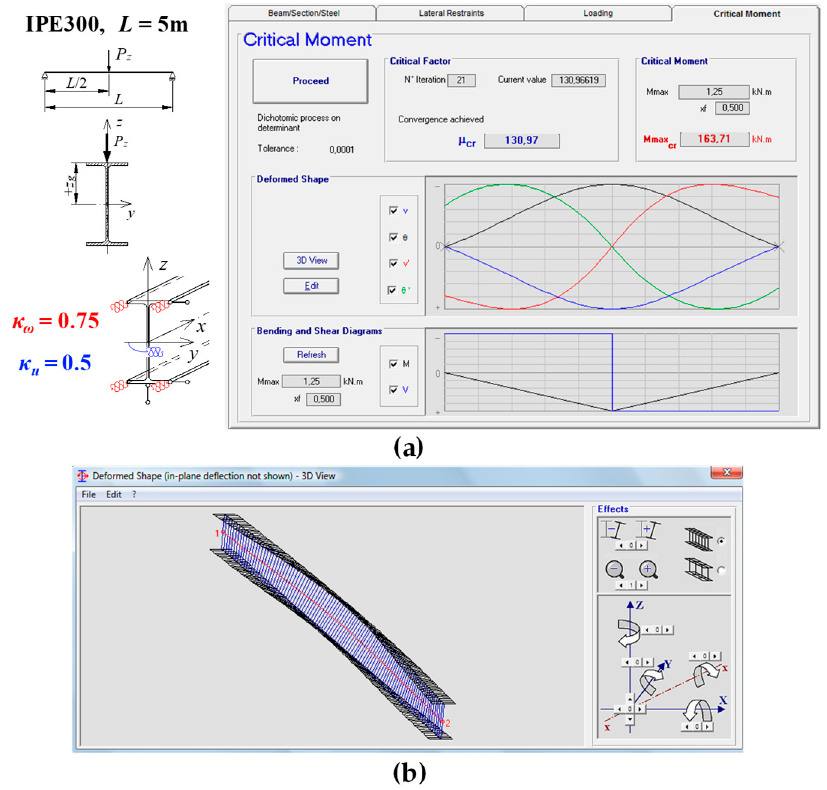
Figure 3. Exemplary beam modeled using the LTBeam software: ( a ) the critical moment for lateral torsional buckling of beam, ( b ) deformed shape of beam.